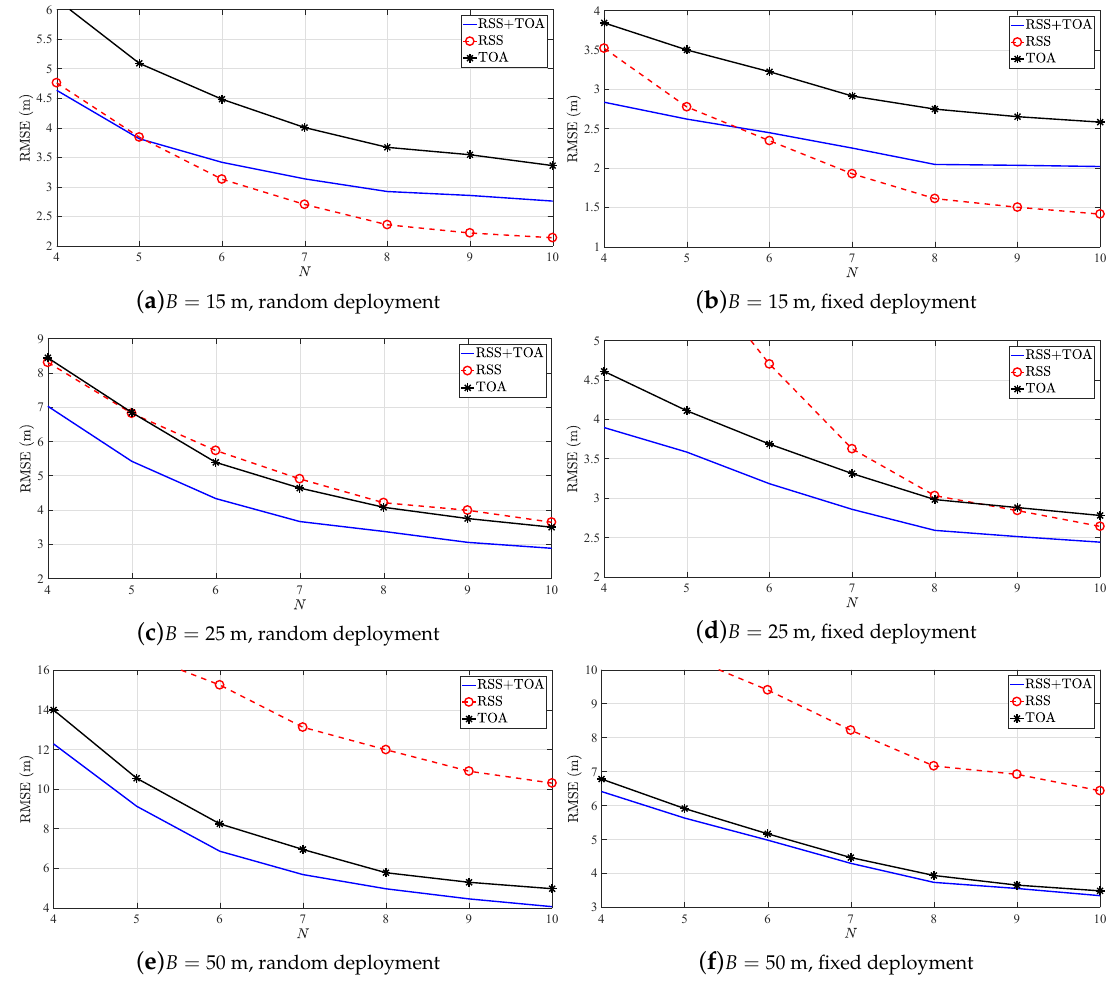
Figure 3. RMSE versus N comparison for